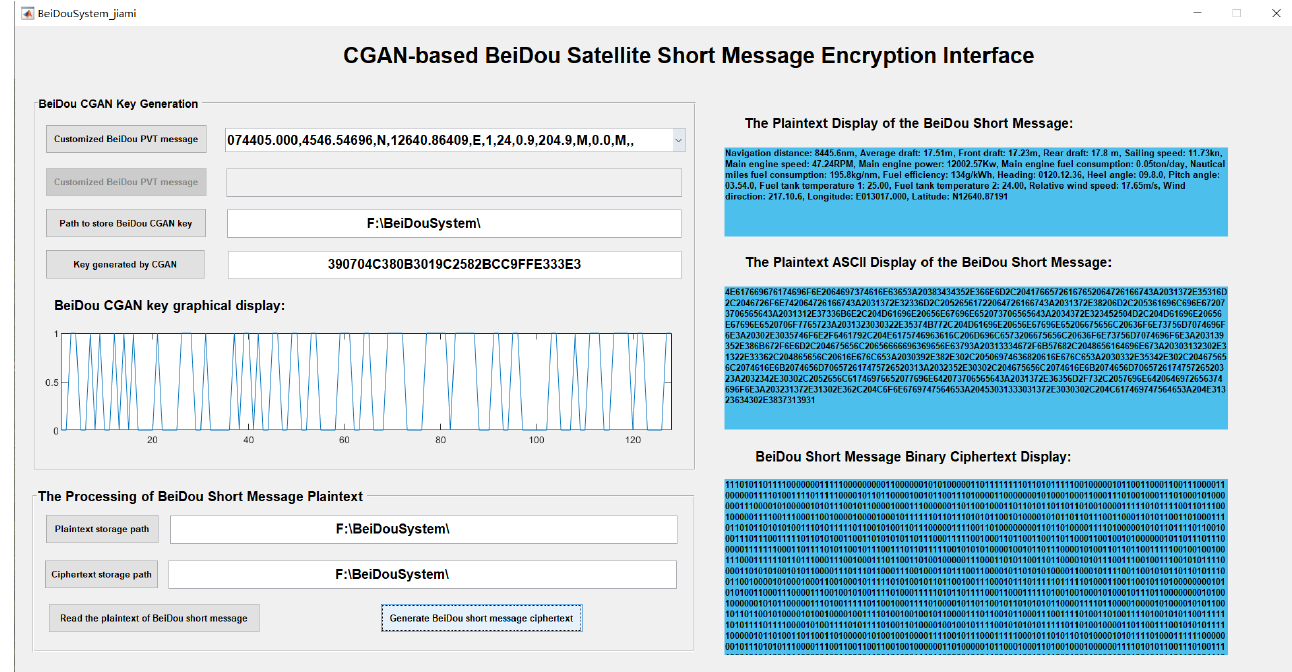
Figure 14. CGAN-based BeiDou satellite short-message-encryption interface.